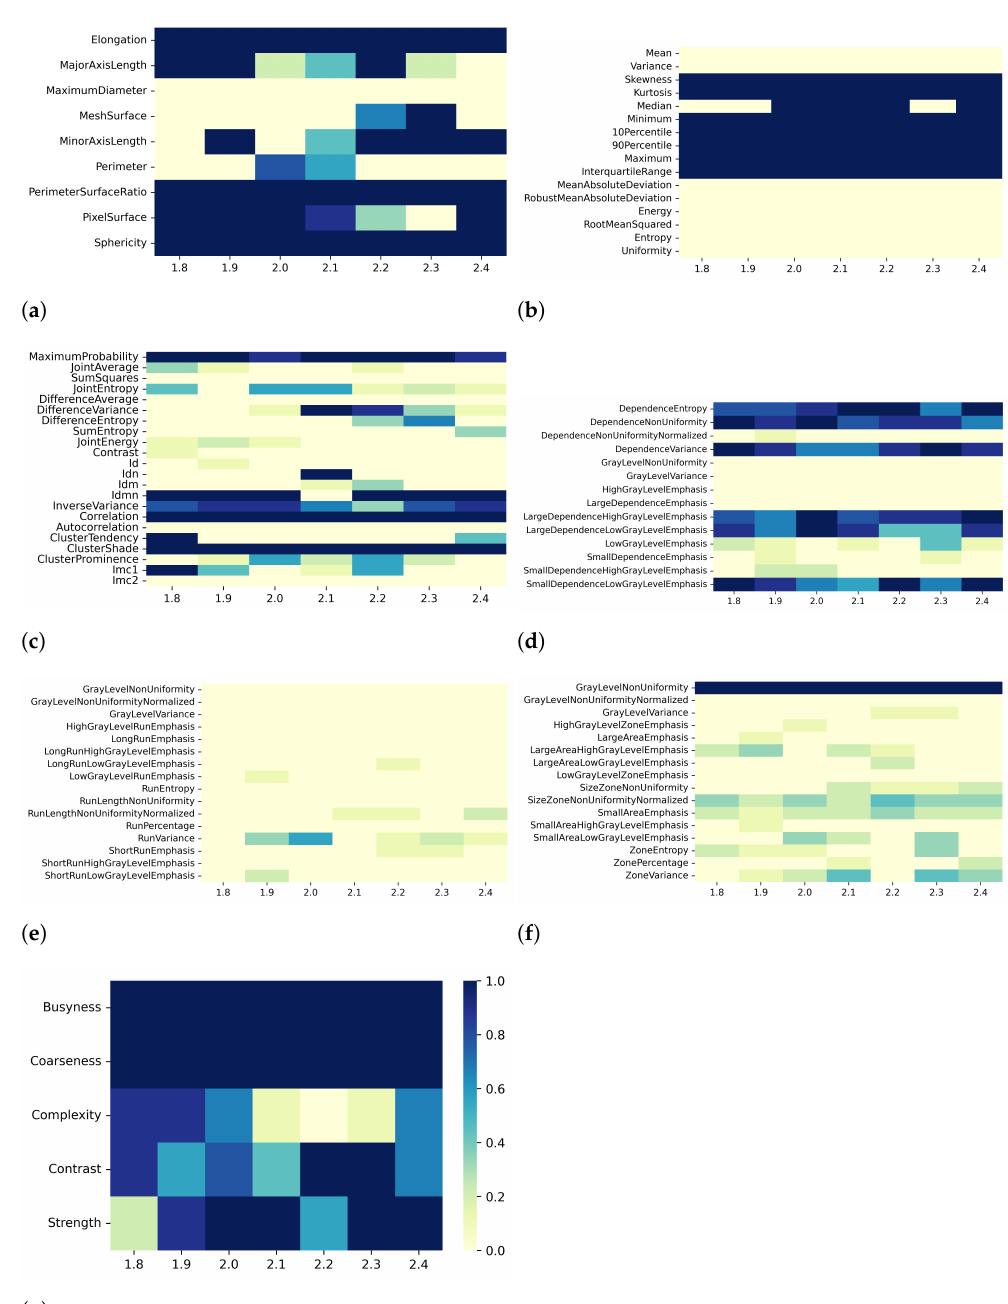
Figure 9. Heatmaps of remaining features from T2 maps after SCC-based dimensionality reduction for effect B (varying discretization bin width, with fixed resampling voxel size (mm)). The radiomic features are separated in classes: ( a ) 2D shape, ( b ) first order, ( c ) GLCM, ( d ) GLDM, ( e ) GLRLM, ( f ) GLSZM, ( g )